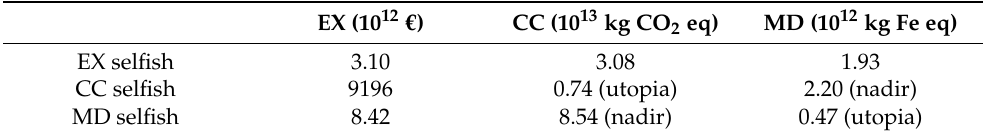
Table 2. Payoff table obtained by the optimizations of a single